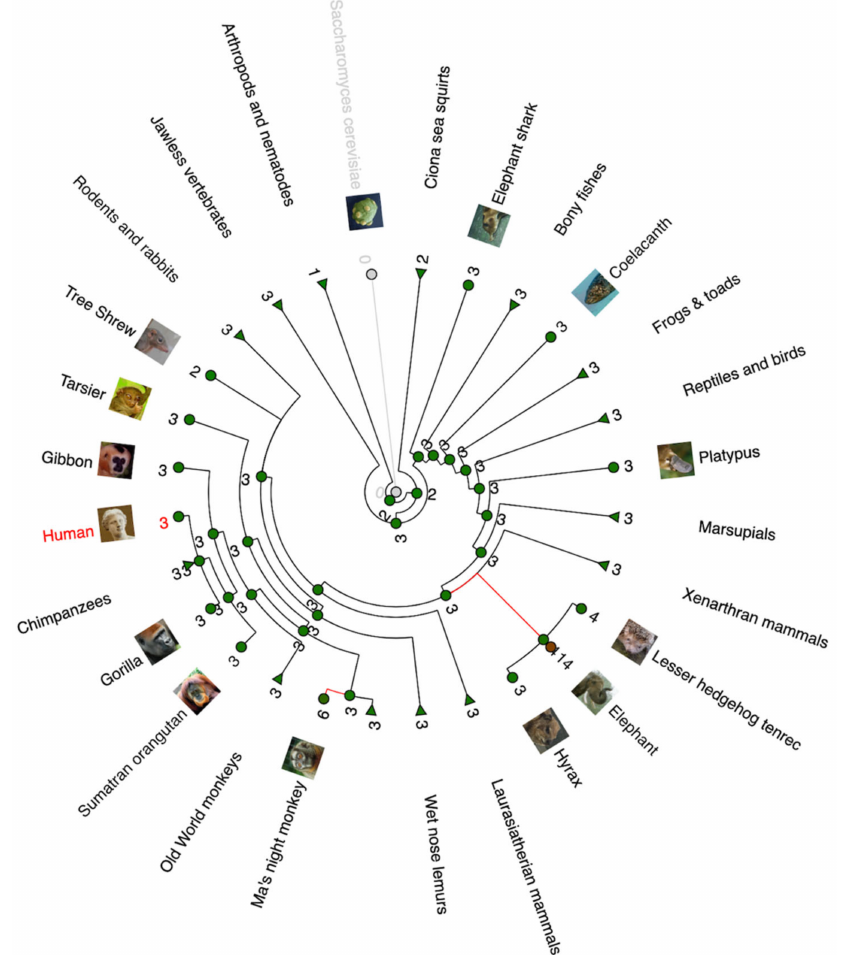
Figure 1. Phylogenetic gain/loss tree of TP53 gene (created in www.ensembl.com on 17 December 2022). The tree shows the number of TP53 paralogues/copies for each species or taxon. Red lines mark significant expansion of the TP53 gene